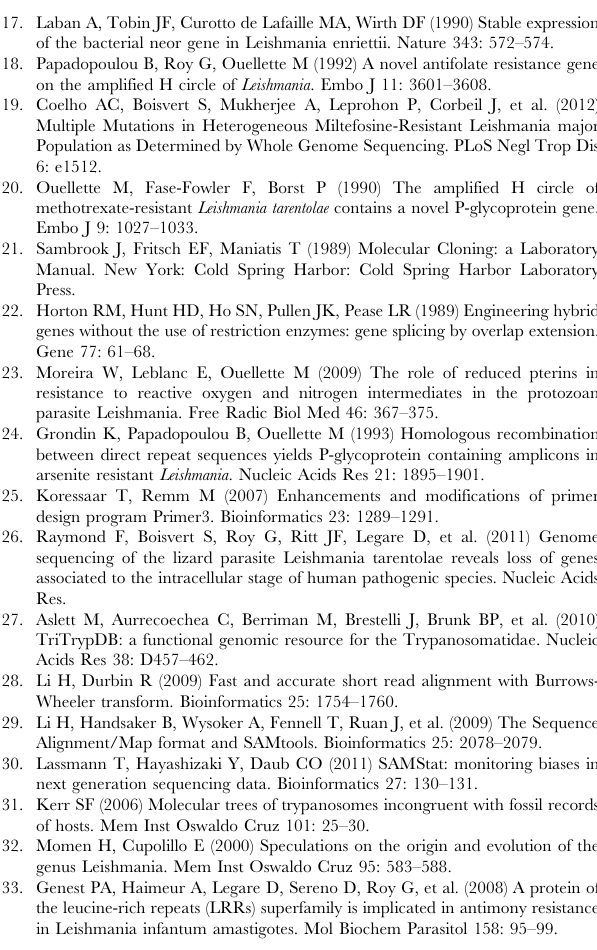
phisms between L. major and L. infantum enabled mapping the size of exchanged DNA by sequencing. The SNPs found in the hybrid L. infantum JPCM5 of Figure 3D are listed by their respective position in the gene. Table S8 Loci analyzed by multilocus sequencing typing genes. Primers forward and reverse were used for both DNA amplification and sequencing (Table S2). The natural polymor- phisms between L. major and L. infantum enabled mapping the size of exchanged DNA by sequencing. The SNPs found in the hybrid L. infantum 263 of Figure 3E are listed by their respective position in the gene. Table S9 Loci analyzed by multilocus sequencing typing genes. Primers forward and reverse were used for both DNA amplification and sequencing (Table S2). The natural polymor- phisms between L. major and L. infantum enabled mapping the size of exchanged DNA by sequencing. The SNPs found in the hybrid 263 (2) of Figure 3F are listed by their respective position in the gene. Table S10 Loci analyzed by multilocus sequencing typing genes. Primers forward and reverse were used for both DNA amplification and sequencing (Table S2). The natural polymorphisms between L. major and L. infantum enabled mapping